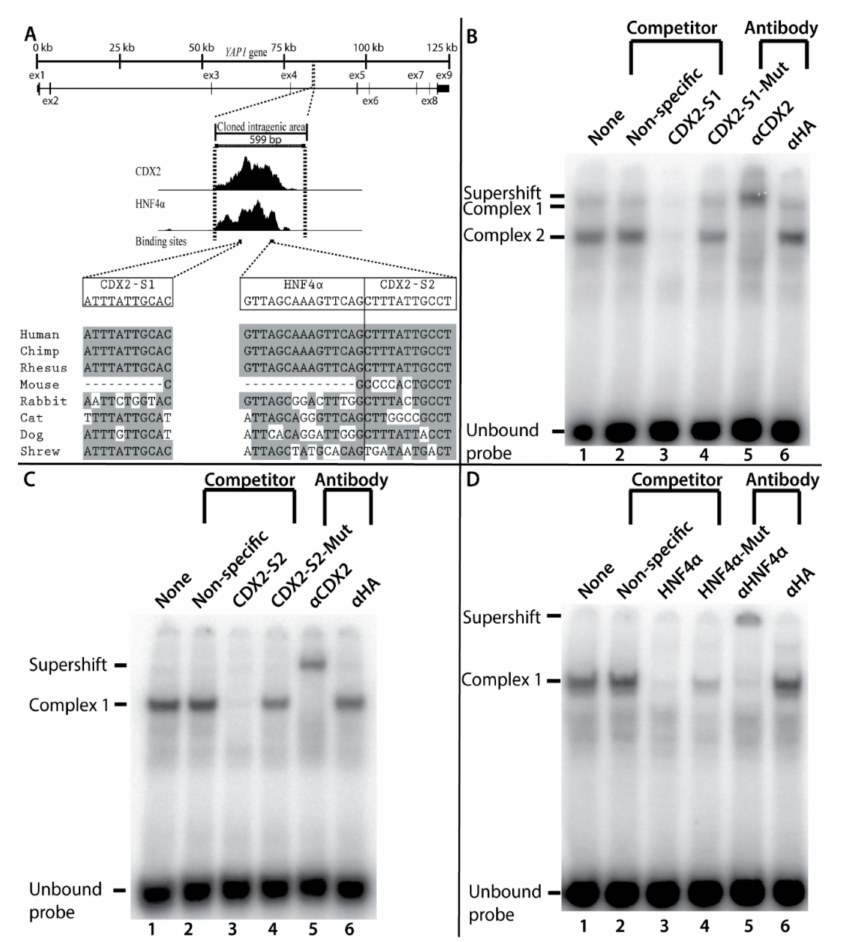
Figure 3. Electrophoretic mobility shift assay and conservation analysis of two CDX2 binding sites and one HNF4 α binding site in the YAP1 + 82 kb enhancer named CDX2-S1 and CDX2-S2 and HNF4 α . ( A ) Alignment of eight vertebrate sequences to identify evolutionary conservation at three detected transcription factor binding sites in the YAP1 + 82 kb enhancer. The dotted lines indicate the borders of the zoomed in-areas and the grey color indicates fully conserved bases that are identical to the human bases; ( B,C,D ) All samples contain: 1 µ L nuclear extract from di ff erentiated Caco-2, 2.5 fmol radioactive labeled probe (unbound probe is seen in the bottom of the image), and 0.5 µ g poly(dI-dC) as a competitor for nonspecific DNA binding proteins. ( B ) In addition, lane 2 contains a non-specific DNA-oligo competitor; lane 3 contains non-labeled CDX2-S1 competitor oligo; lane 4 contains mutated non-labeled competitor oligo CDX2-S1-Mut; lane 5 contains CDX2 specific antibody ( α CDX2); lane 6 contains anti-hemagglutinin ( α HA) control antibody; ( C ) Same as in B, but with CDX2-S2 oligo and CDX2-S2-Mut oligo; ( D ) Same as in C, but with HNF4 α oligo, HNF4 α -Mut oligo, and anti-HNF4 α antibody ( α HNF4 α